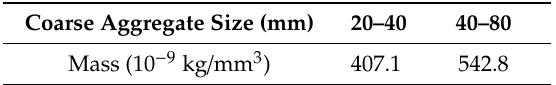
Table 3. Aggregate proportions of three-graded concrete [25].